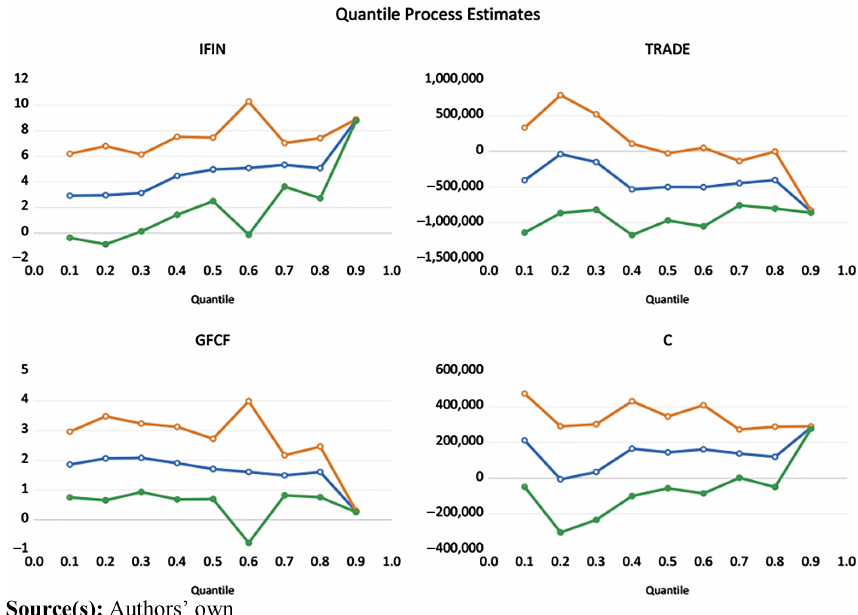
Figure 2. Markov chain marginal bootstrap (MCMB-A) quantile process estimates